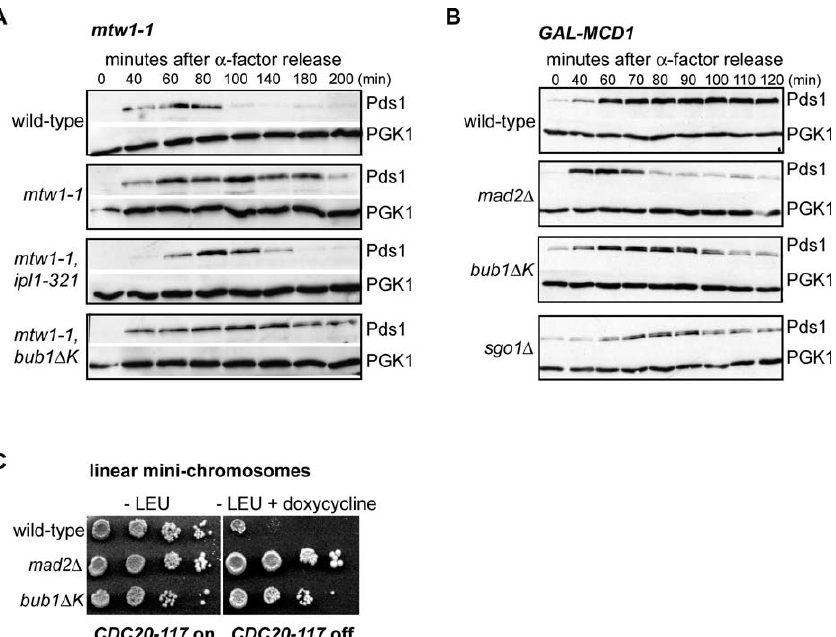
Figure 2. Bub1 Kinase Domain Is Required to Arrest in Response to Reduced Cohesion (A) Wild-type (JF004), mtw1–1 (SBY1646), mtw1–1 , bub1 D K (JF100), and mtw1–1 , ipl1 -321 (SBY1724) strains carrying the temperature-sensitive allele mtw1–1 and Pds1-18Myc were synchronised in G1 for 2.5 h then incubated at the restrictive temperature 36 8 C for 30 min before release. The levels of Pds1 were monitored by immunoblotting with A14 anti-myc antibody and anti-PGK1 as a loading control. (B) Wild-type (VBI545), bub1 D K (JF023), mad2 D (VBI560), and sgo1 D (JF224) strains, containing Pds1-myc, were synchronised in G1 with a -factor in media containing 2% galactose and 2% raffinose to maintain Mcd1 expression. Mcd1 was then turned off by incubating them in media containing glucose and a -factor for 3 h. The cells were then released into rich media containing glucose, and samples for immunoblotting were taken at indicated times.